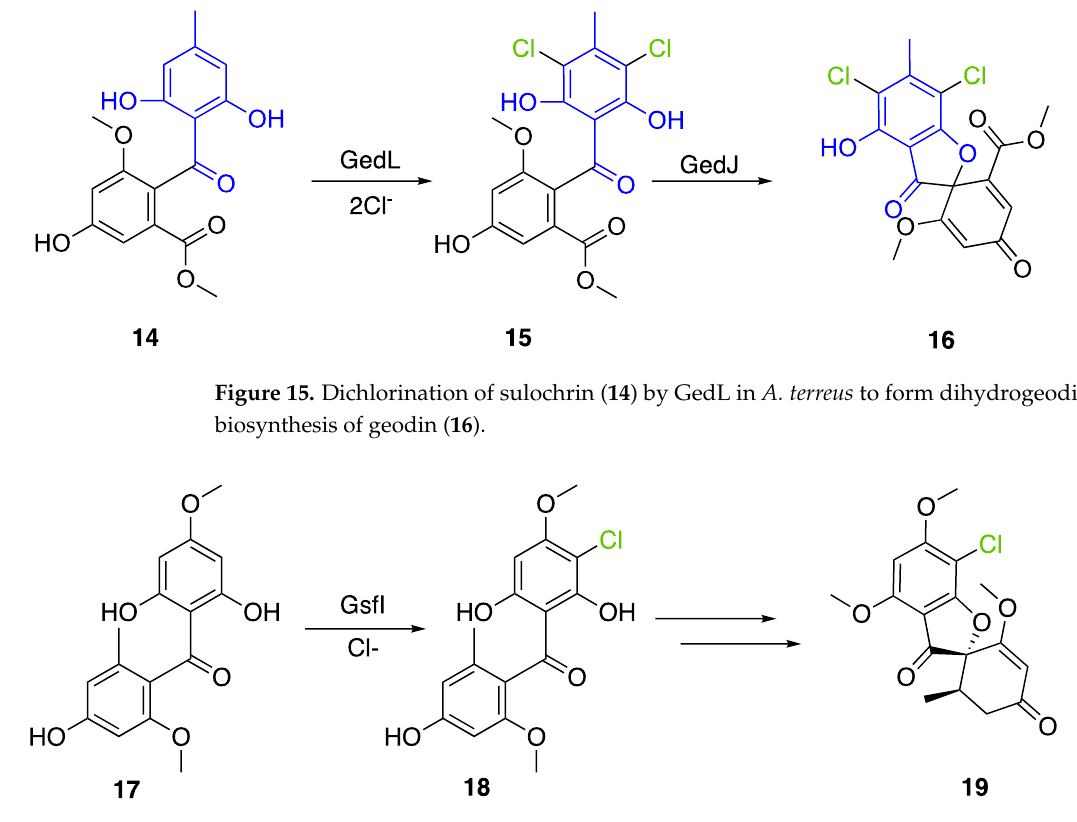
Figure 15. Dichlorination of sulochrin ( 14 ) by GedL in A. terreus to form dihydrogeodin ( 15 ) in the biosynthesis of geodin ( 16 ).